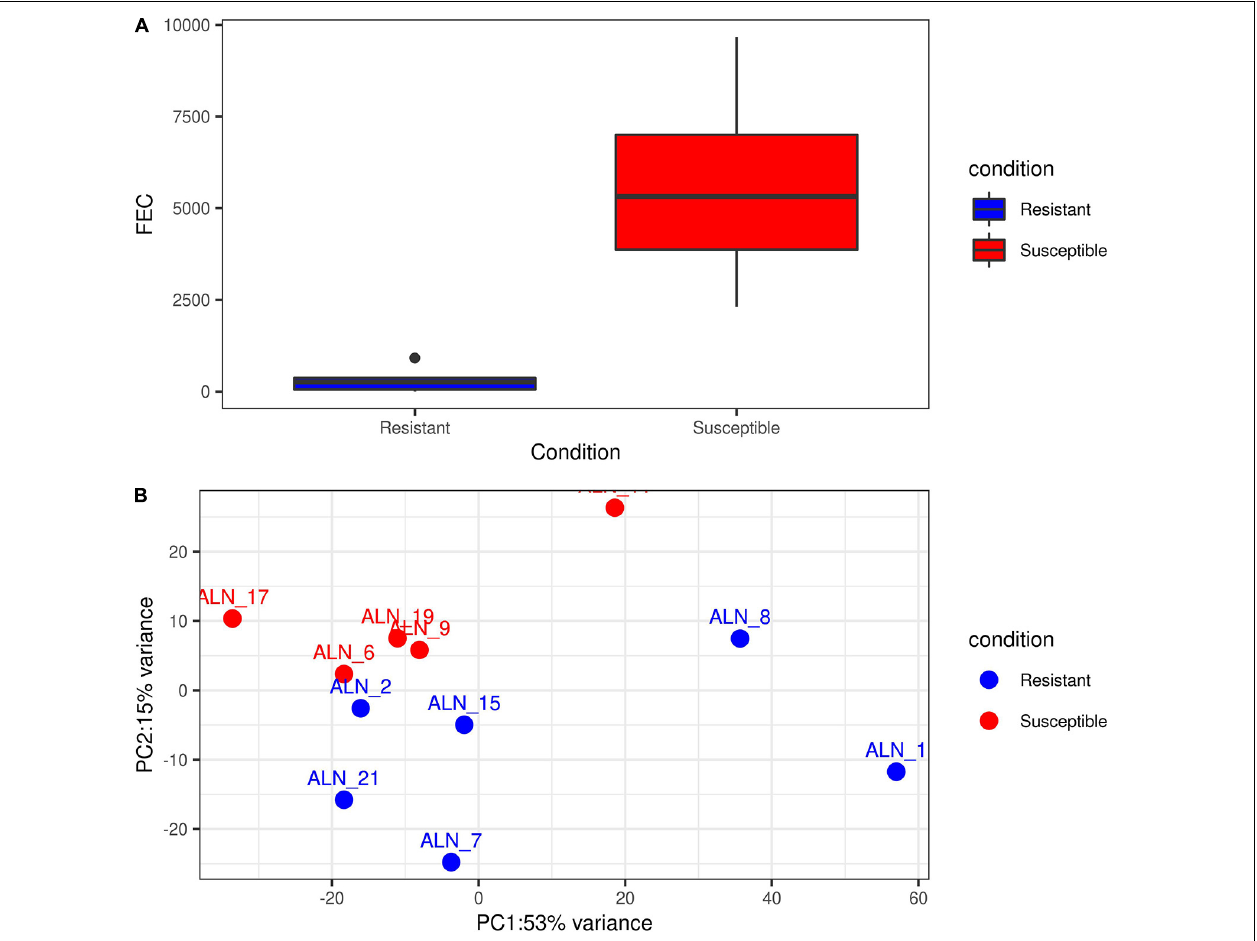
FIGURE 1 | Exploratory plots of GIN infected resistant and susceptible sheep. (A) Distribution of accumulated fecal egg count (FEC) in resistant and susceptible sheep after a second experimental infection with GIN Teladorsagia circumcincta. Blue box represents the group mean of the resistant group and red box represents the group mean of the susceptible group. (B) PCA performed with the read count matrix of the 11 ALN RNA-seq datasets finally included in the differential gene expression analysis specifying the sample condition [resistant (6) and susceptible